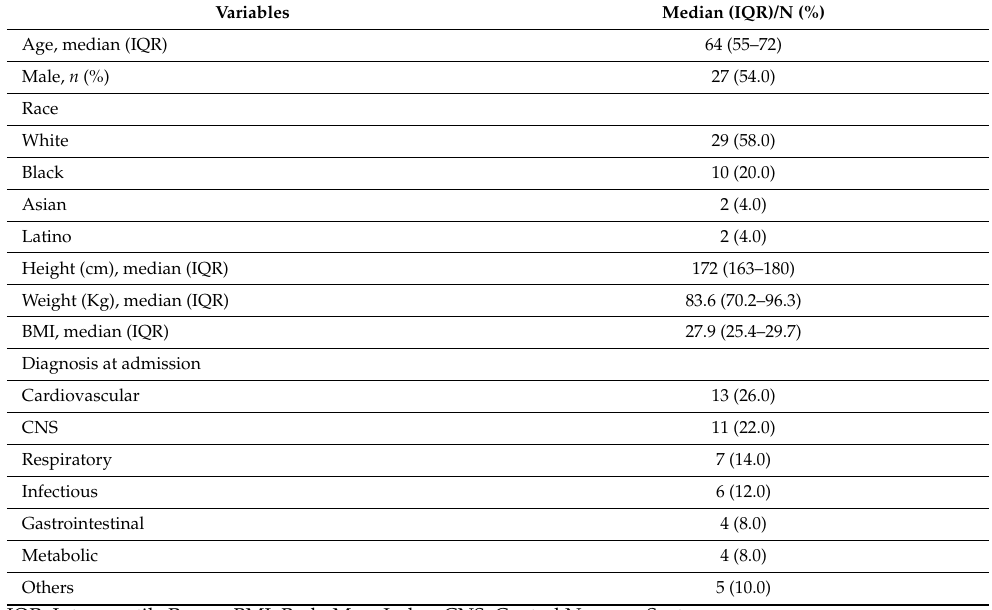
Table 1. Demographics of the included